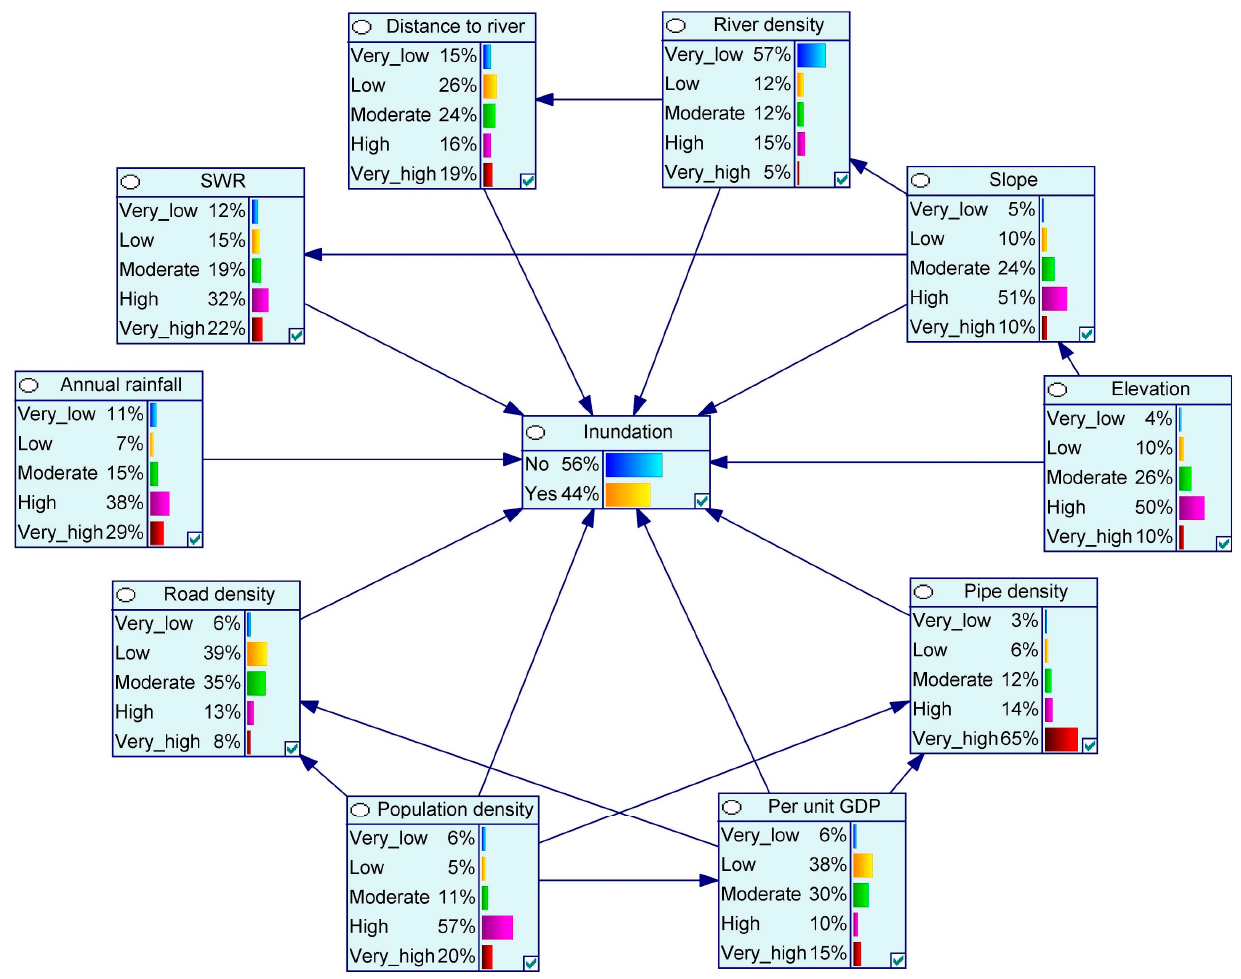
Figure 5. Bayesian network (BN) model for urban flood inundation risk assessment.